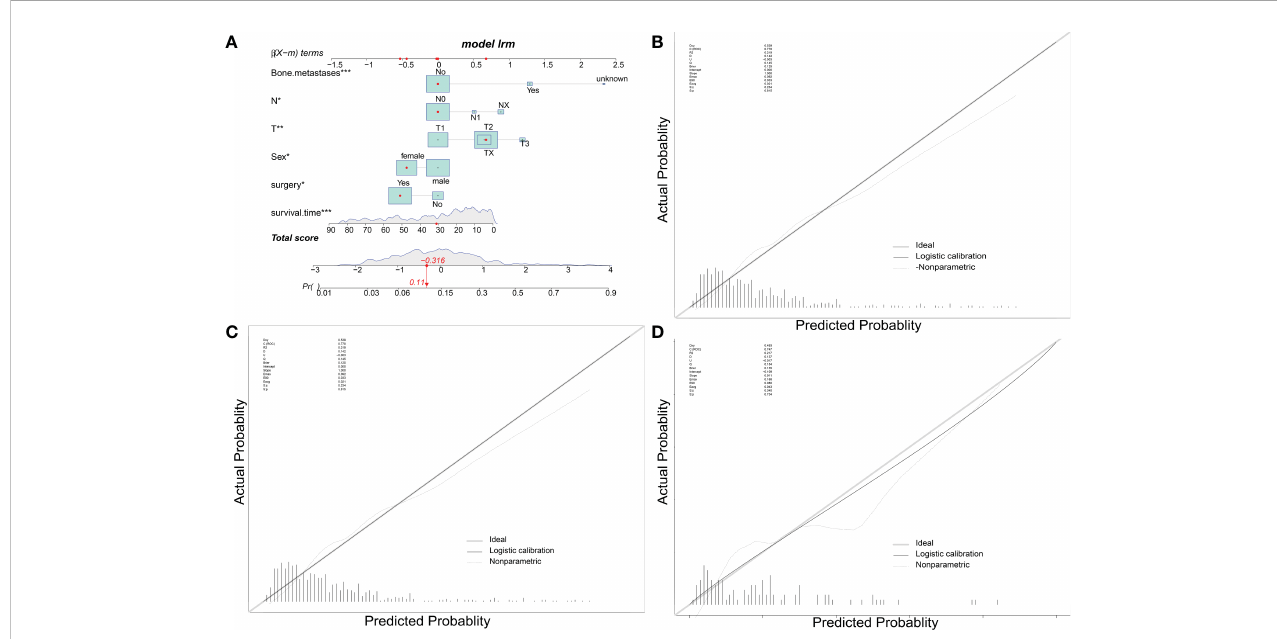
FIGURE 1 Nomogram predicts LM in patients with osteosarcoma. The LM Nomogram (A) contains six prognostic factors and illustrates the risk of LM in patients by mapping their values to covariate scales. The calibration curves for the prediction training group (B) , internal validation group (C) and multicentre validation group (D) are shown on the